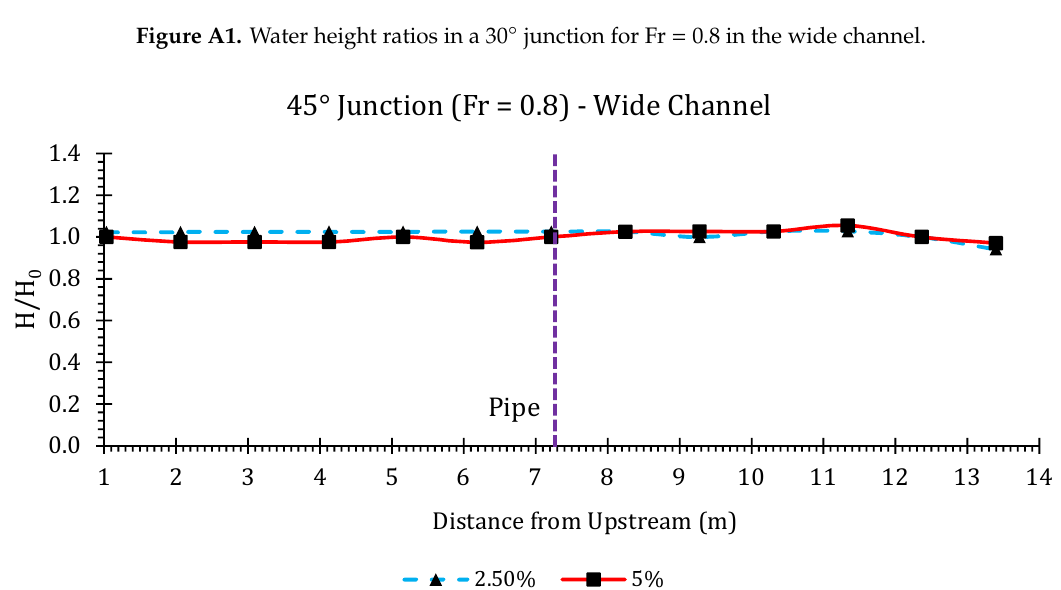
Figure A2. Water height ratios in a 45° junction for Fr = 0.8 in the wide channel.